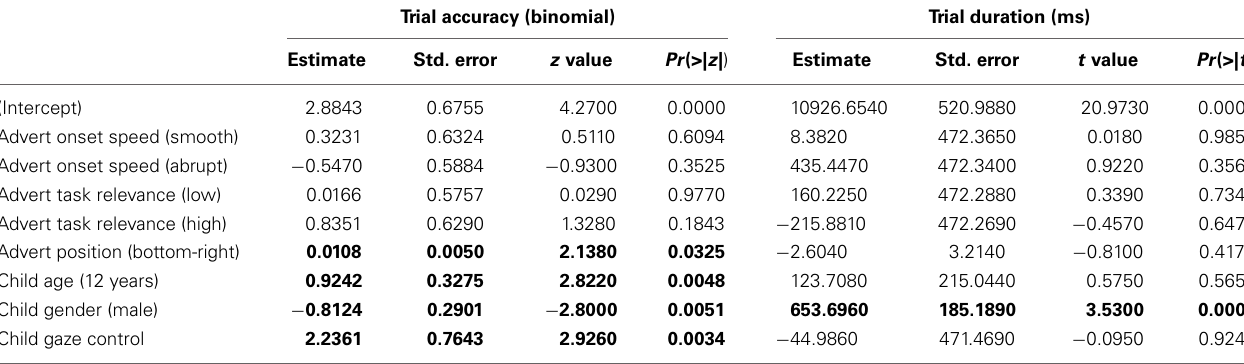
Table 1 | Effects of independent variables on task performance measures (trial accuracy and trial duration).